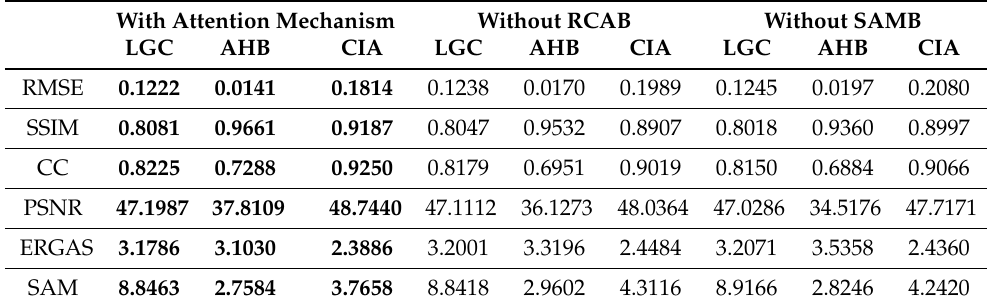
Table 5. Evaluation metrics on the results of ablation experiments of attention mechanism on different datasets. Bold values indicate the best